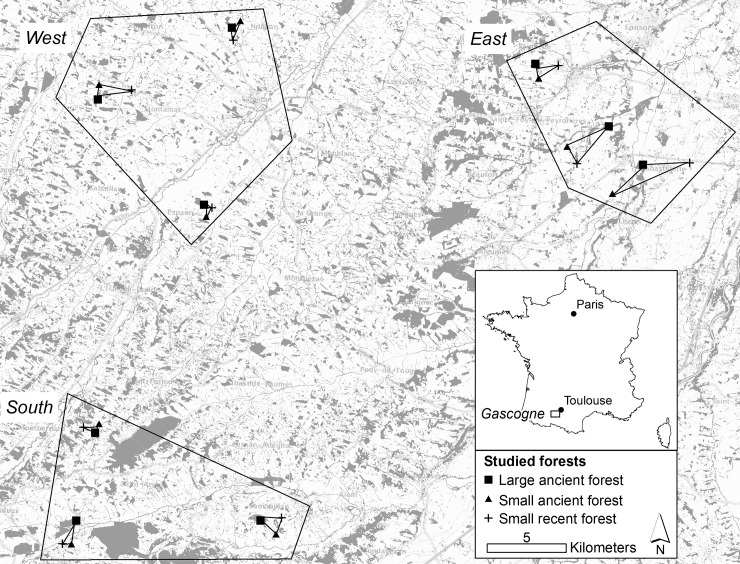
Sampling plan: 27 forests were sampled in a highly fragmented region.Grey indicates forest in the landscape.